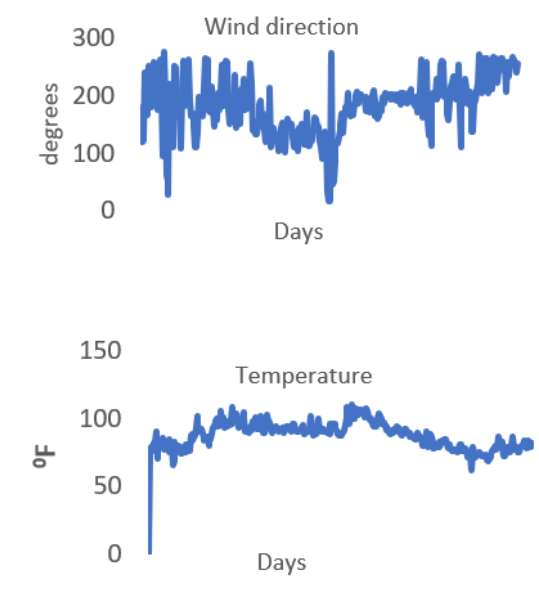
Figure 3. Statistical measured data at site.